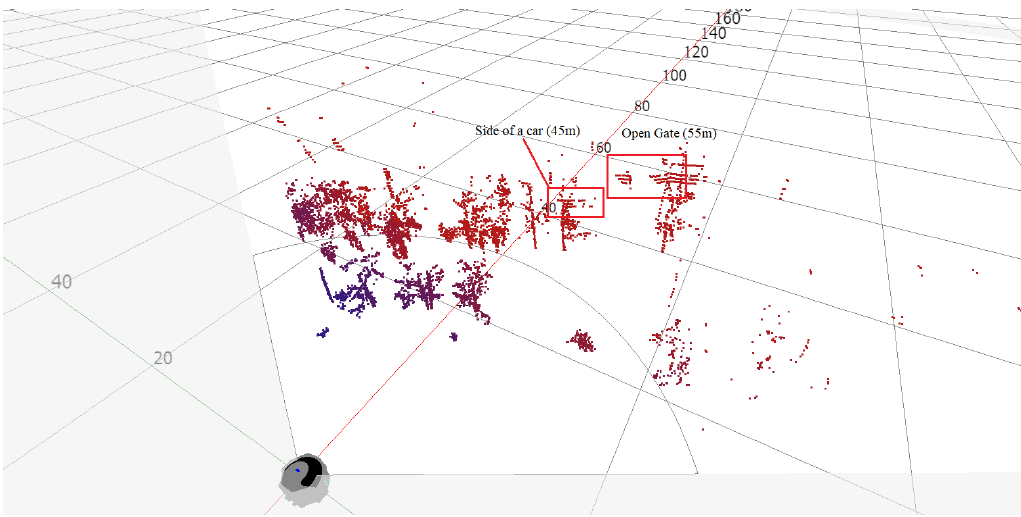
Figure 21. Scan of the Test Area